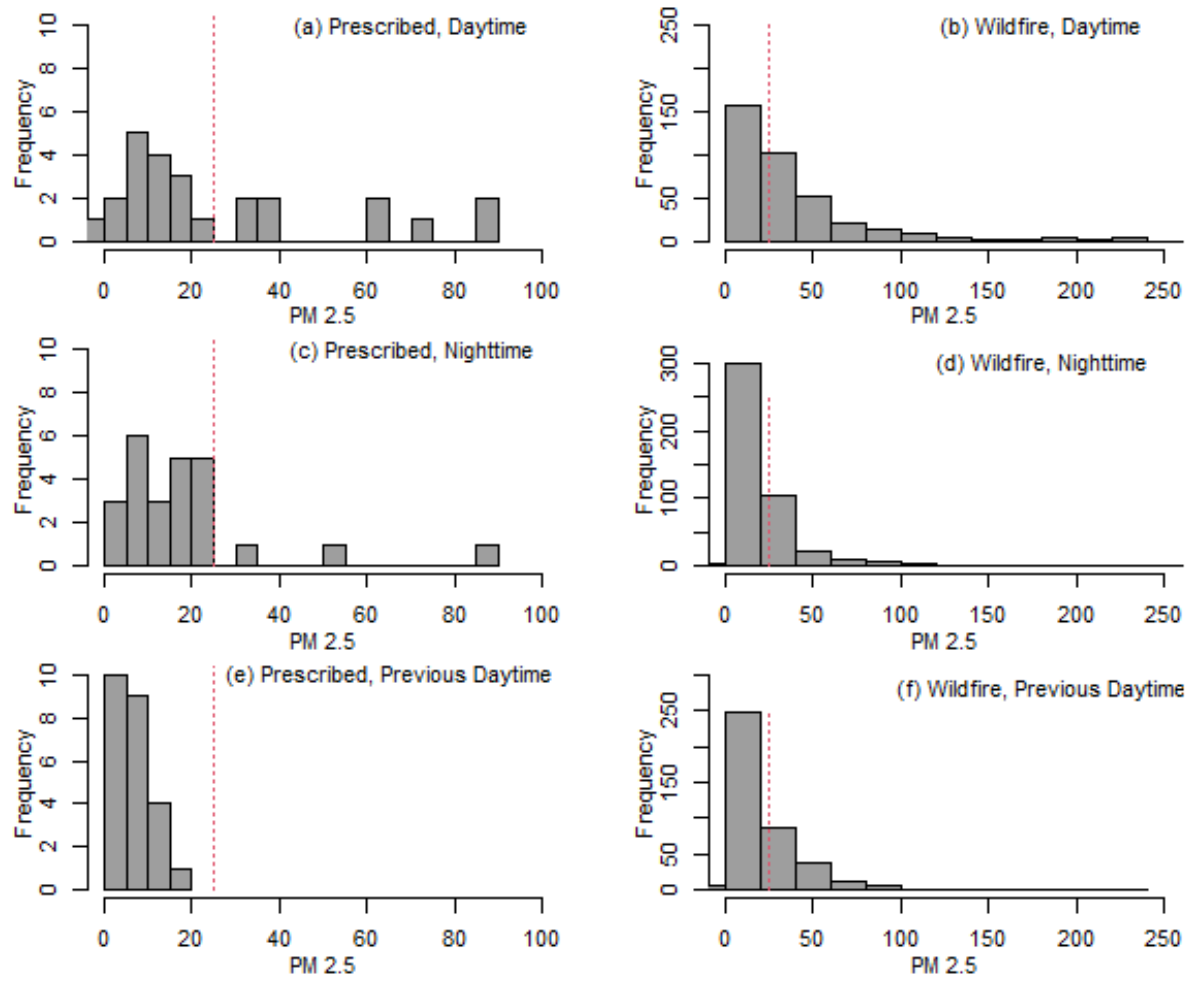
Figure 4. Distribution of PM 2.5 values for the plumes that passed over an air-quality monitor: For prescribed burns ( a ) during the day of the overpass, ( c ) the following night, and ( e ) the previous daytime for comparison. ( b , d , f ) are the same for wildfires. The vertical dotted line is the exceedance level (25 μ gm − 3 ).